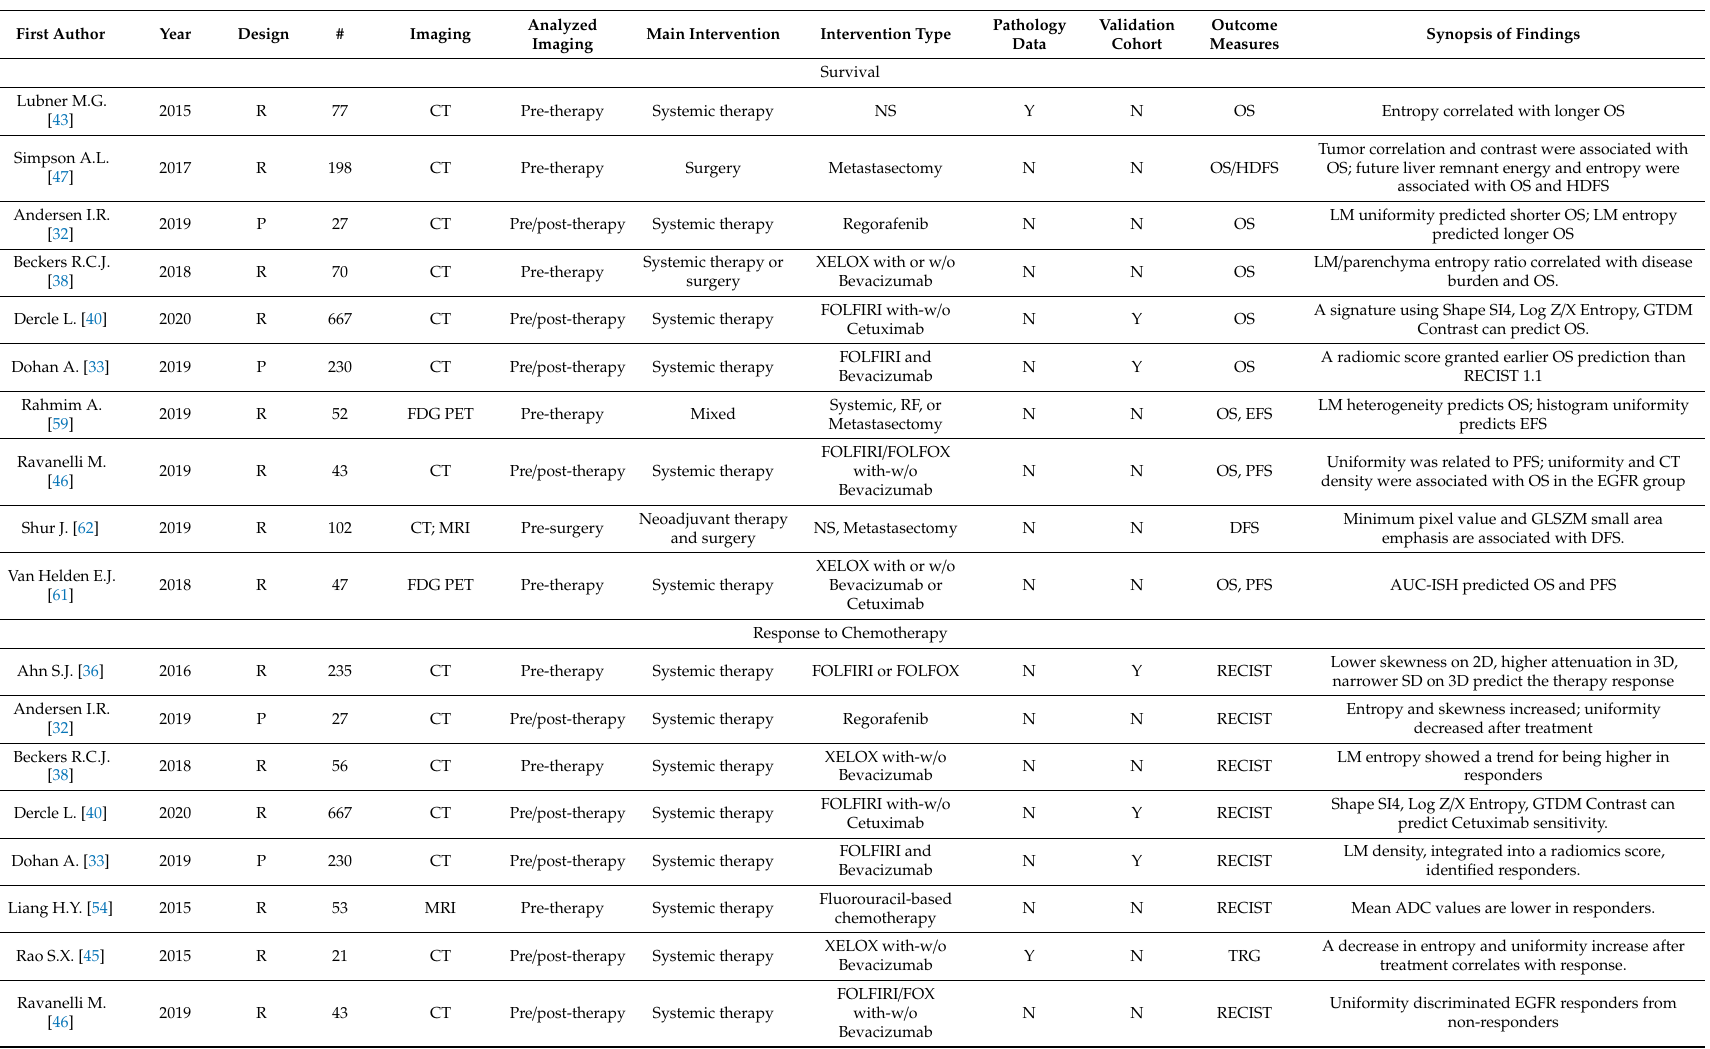
Table 4. Studies on radiomics in patients with liver metastases from colorectal